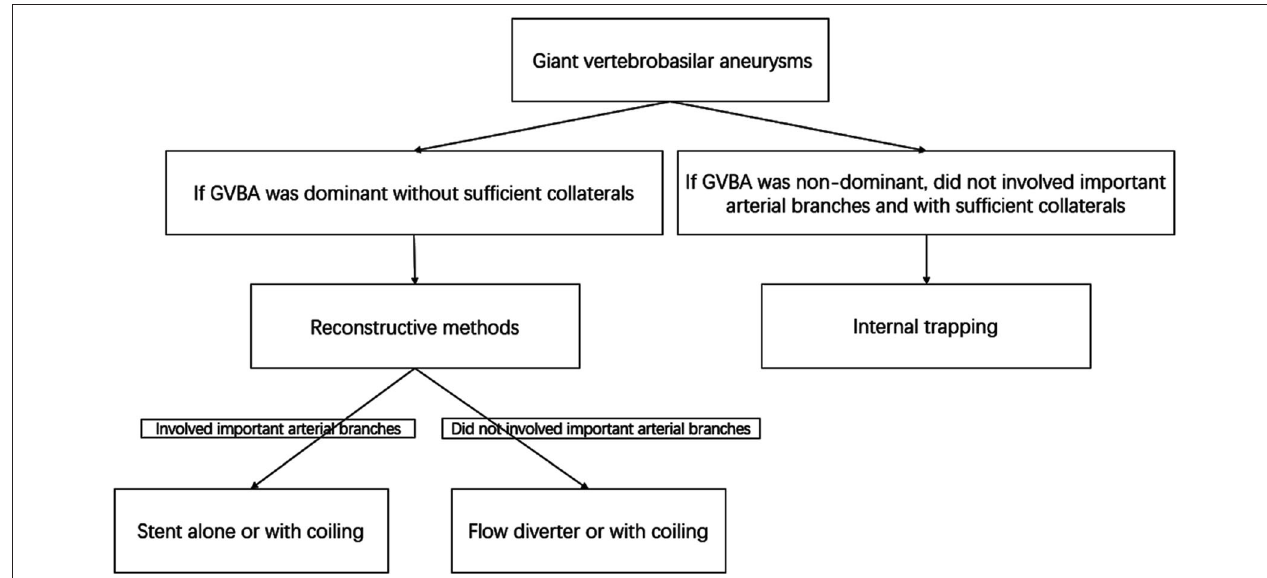
FIGURE 1 | Flow chart of the decision concerning endovascular treatment methods for giant vertebrobasilar